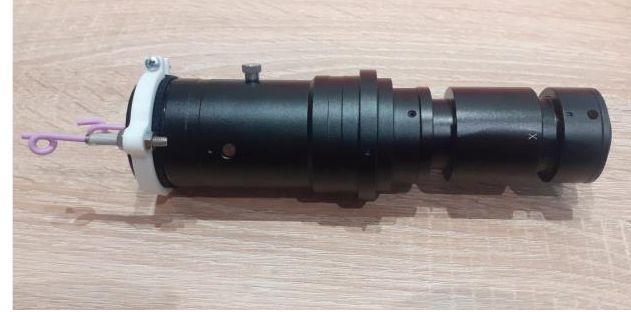
Figure 32. Lens set already with a textile yarn holder.